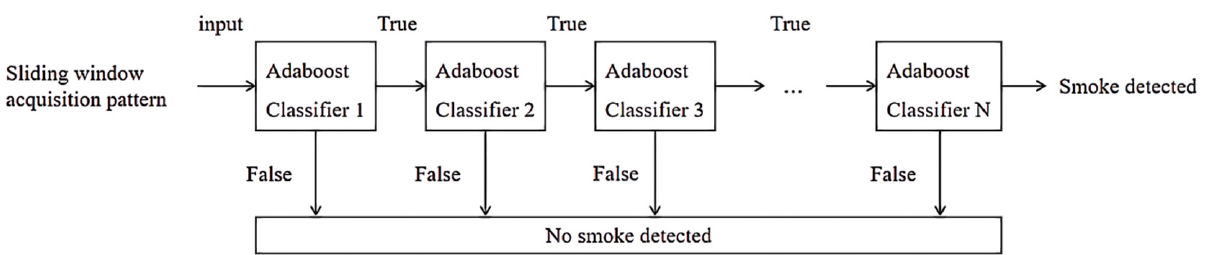
Figure 8. Cascade classifier structure diagram. Algorithm 1 The Detailed Cascade Classifier Training